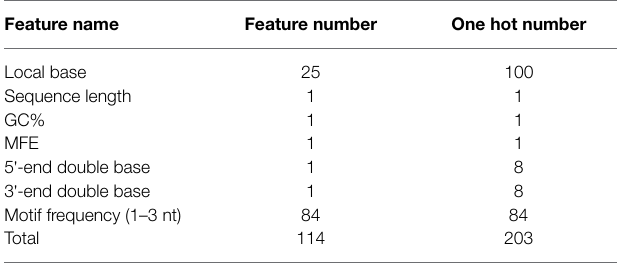
TABLE 4 | Features selected by prediction